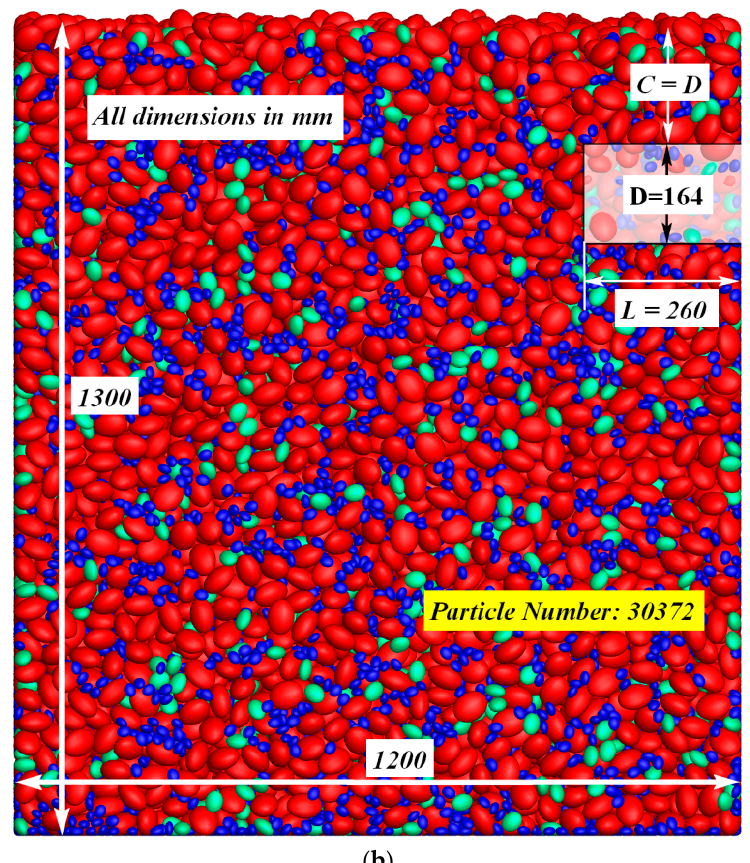
Figure 12. Overview of the discrete element model for the 1 g model test (all dimensions in mm): ( a ) Model tank and particles prior to deposition; and ( b ) tunnel excavation region inside the model tank.